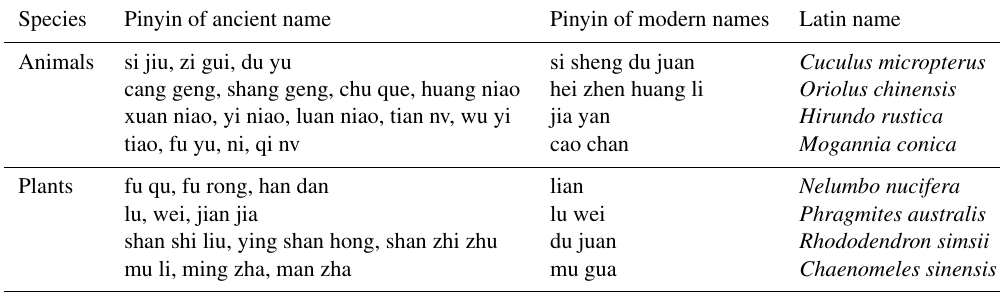
Table 4. Comparisons among the ancient, modern, and Latin names of several common species. Species Pinyin of ancient